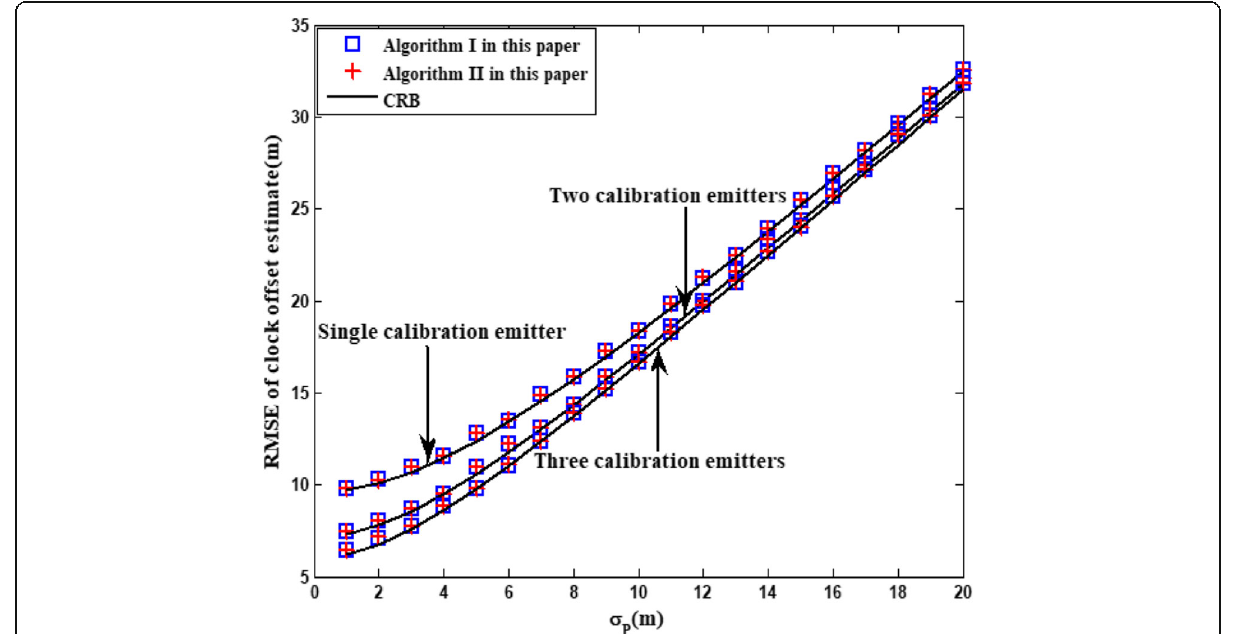
Fig. 20 RMSE of clock offset estimate versus σ P for a different number of calibration emitters